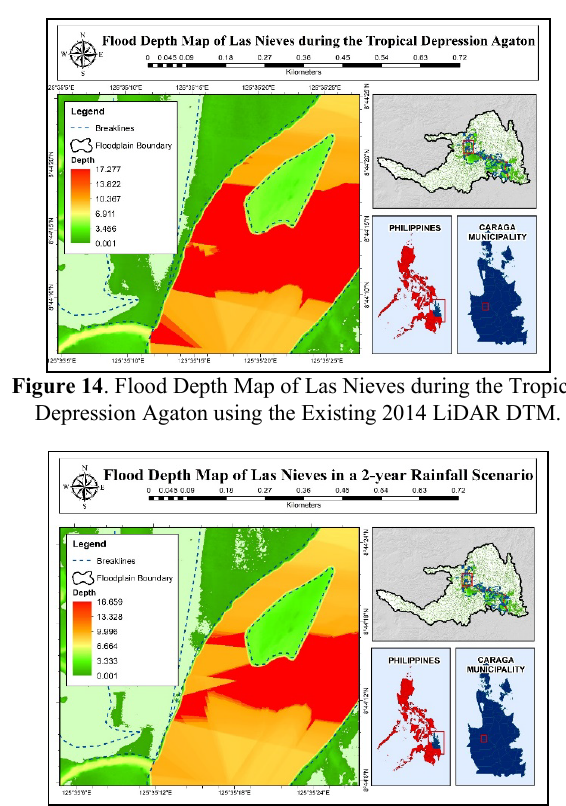
Figure 15 . Flood Depth Map of Las Nieves during the 2-year Rainfall Scenario using the Existing 2014 LiDAR